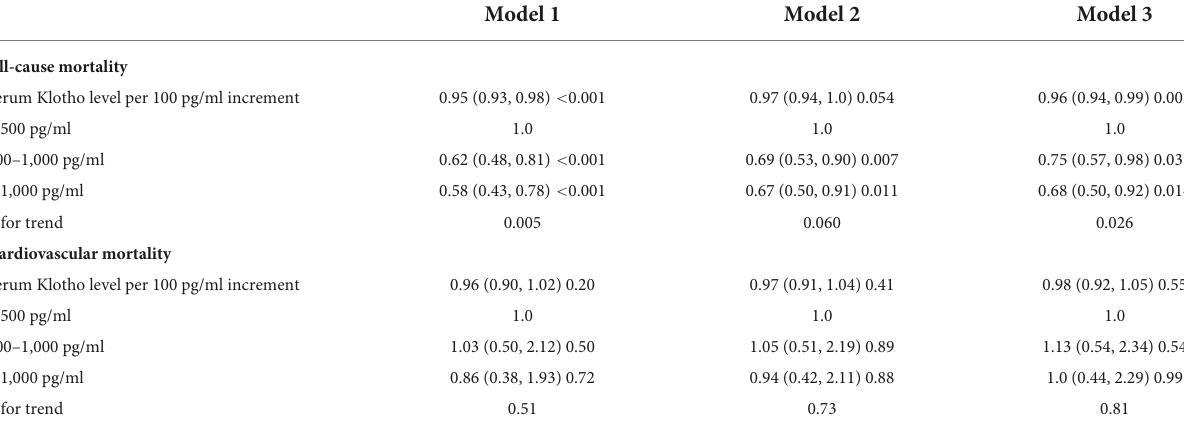
TABLE 4 Cox proportional hazards analysis for all-cause and cardiovascular mortality according to serum Klotho concentrations in American hypertensive populations with imputed variables from multiple